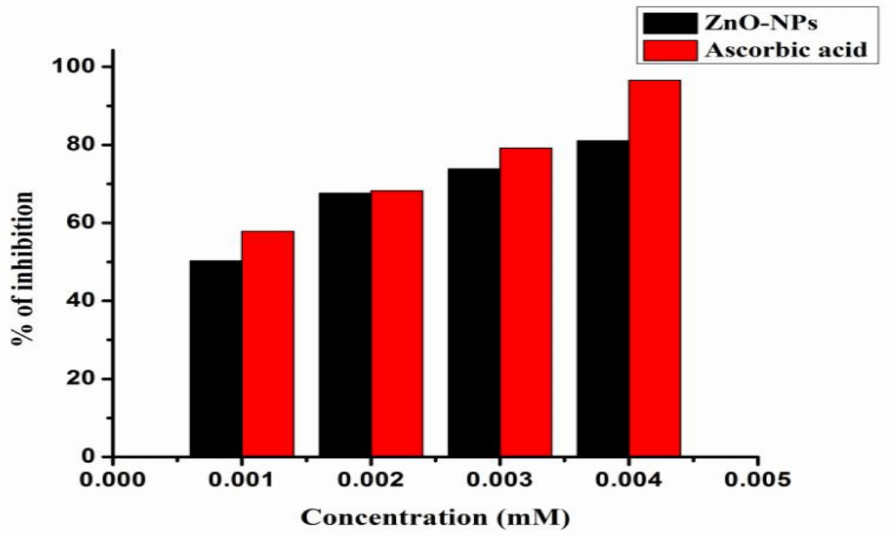
Figure 10. Antioxidant activity of ZnO nanoparticles, compared with standard ascorbic acid.